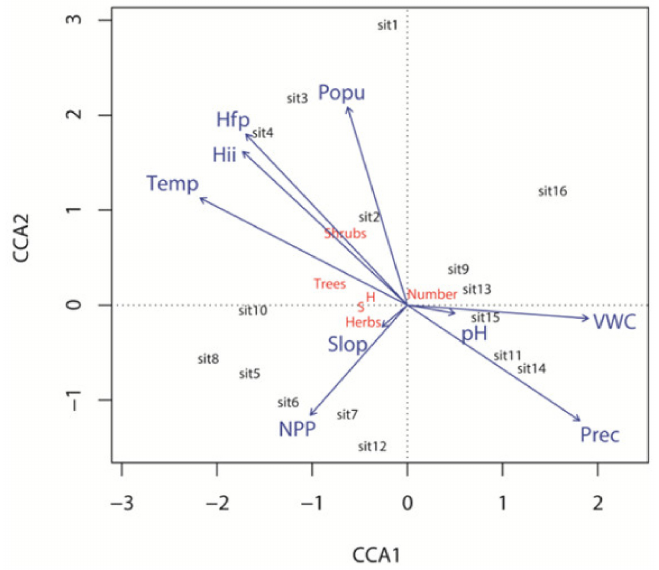
Figure 4. CCA ordination showing the relationship between environmental factors and altitudinal plant patterns in the Taihang Mountain study area, northern